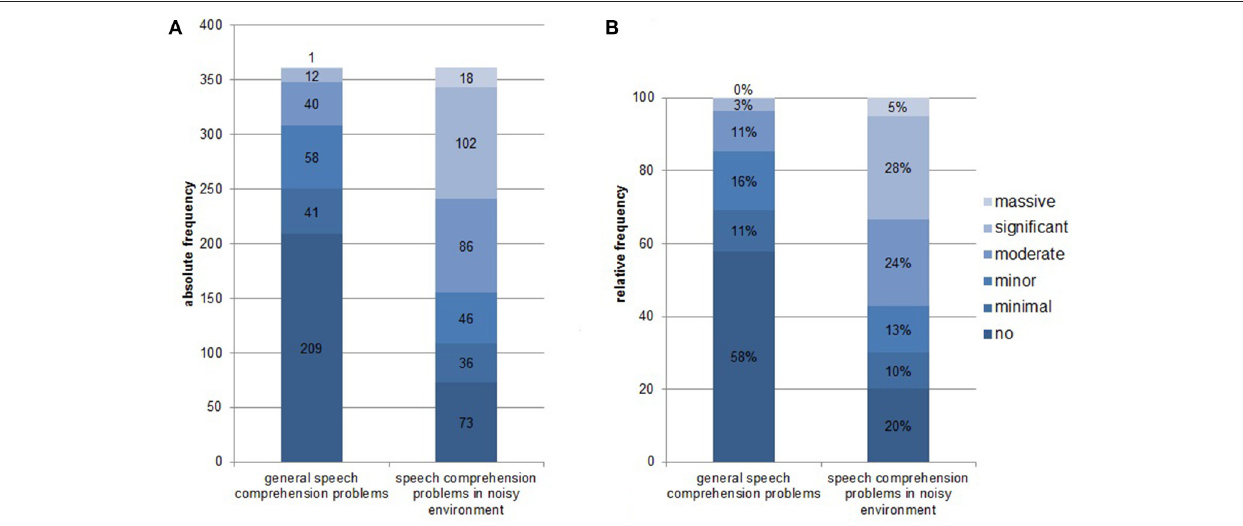
FIGURE 1 | Distribution of answers from the speech comprehension questions [“How would you rate your ability to understand speech?” and “How would you rate your ability to follow a conversation when multiple people are speaking simultaneously (e.g., in restaurant situation)? on a scale ranging between 0, no problems; 1, minimal problems; 2, minor problems; 3, moderate problems; 4, significant problems; to 5, massive problems]. (A) Absolute frequency of distribution; (B) Relative frequency of